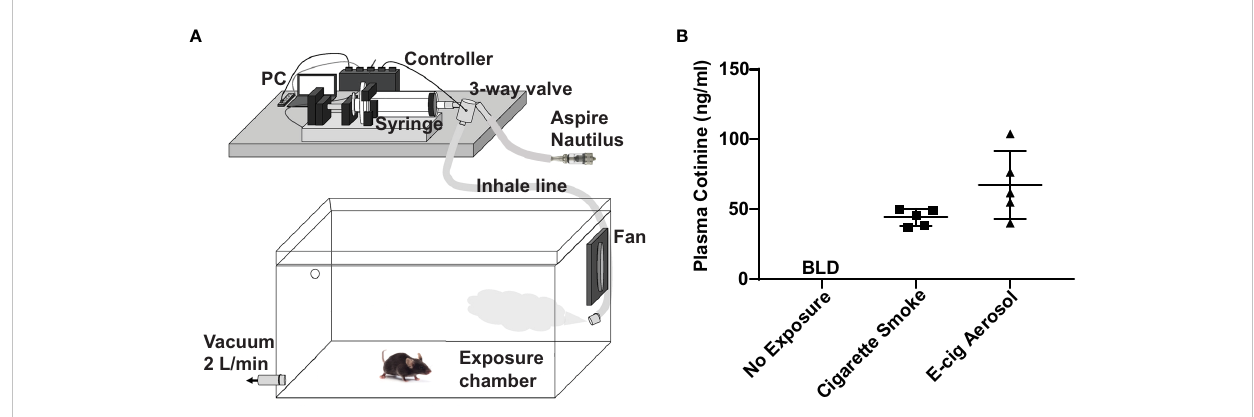
FIGURE 1 E-cigarette aerosol exposure system achieves appropriate plasma cotinine levels in mice. (A) Mice were housed in a plexiglass chamber. E-cigarette aerosol was generated by the tank-style Aspire Nautilus and drawn into a syringe by the Gram Universal Vaping Machine controlled by programmed computer software. The aerosol was injected through a three-way valve into the exposure chamber and circulated by a fan. A vacuum was used to maintain a steady-state and draw in fresh air and aerosol. (B) Plasma cotinine levels in mice exposed for nine days, one hour/day, to aerosol generated by the Nautilus device containing an e-liquid mixture of vegetable glycerin (VG), propylene glycol (PG), and 36 mg/ml nicotine was not signi fi cantly different (P = 0.099, unpaired t-test) to that of mice exposed to cigarette smoke. Cigarette smoke exposures were over fi ve hours (single day) with a Teague TE-10 smoking machine using 3R4F Kentucky research cigarettes, as in our prior studies (18, 19). Plasma cotinine in unexposed mice was below the limit of detection (BLD). Data are presented in nanogram/milliliter (ng/ml). Each data point represents one